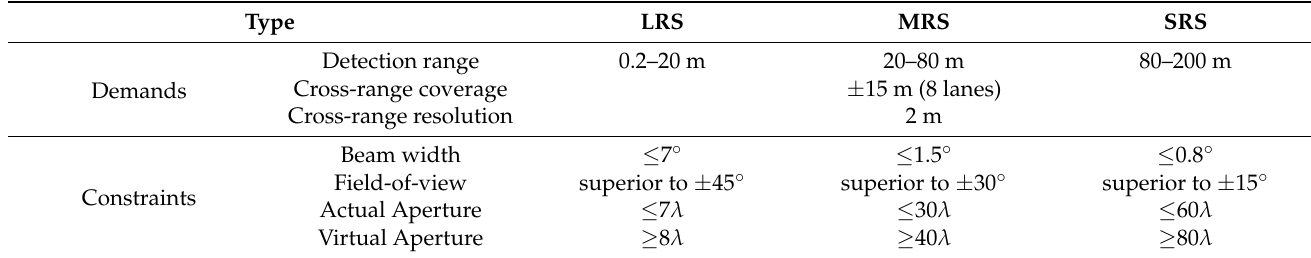
Table 2. The technical parameters for multi-subarray in reference to [10,15] .